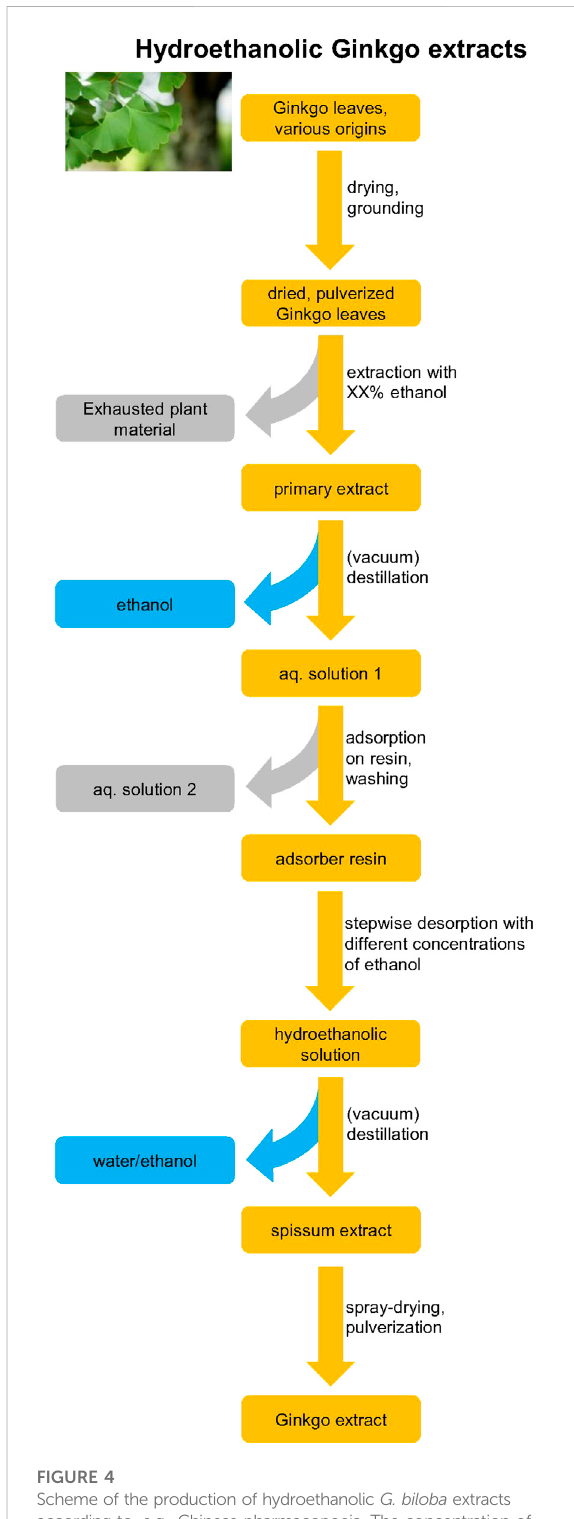
FIGURE 4 Scheme of the production of hydroethanolic G. biloba extracts according to, e.g., Chinese pharmacopoeia. The concentration of ethanolusedforprimaryextractionmayvaryfrom30to95%between manufacturers. Color coding: orange – value phase, gray – waste phase, blue – solvents. The hydroethanolic process differs to a major extent from the EGb 761 ®